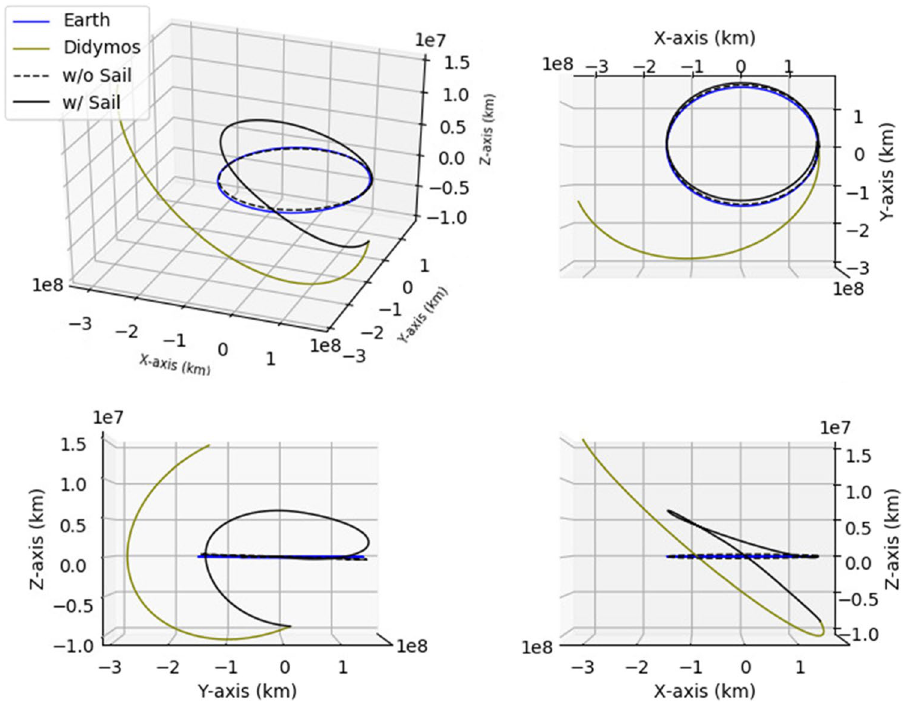
Figure 11. Didymos interception for a tof of 398 days and sail loading of 61.2g / m 2